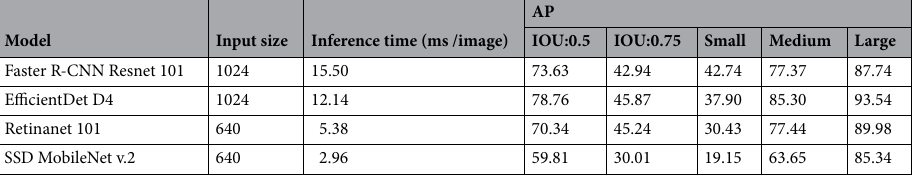
Table 1. Test results of detection models.